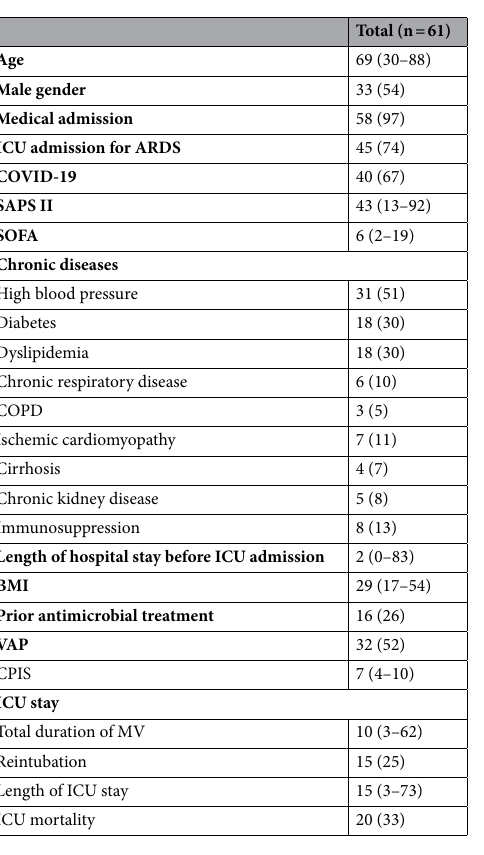
Table 1. Characteristics of study patients from ETT collection. All results are displayed as number (%) for categorical variables and as median (IQR) for quantitative variables. ARDS acute respiratory distress syndrome, BMI body mass index, COPD chronic obstructive pulmonary disease, CPIS clinical pulmonary infection score, MV mechanical ventilation, ns not significant, SAPS simplified acute physiology score, SOFA sepsis-related organ failure assessment, VAP ventilator-associated